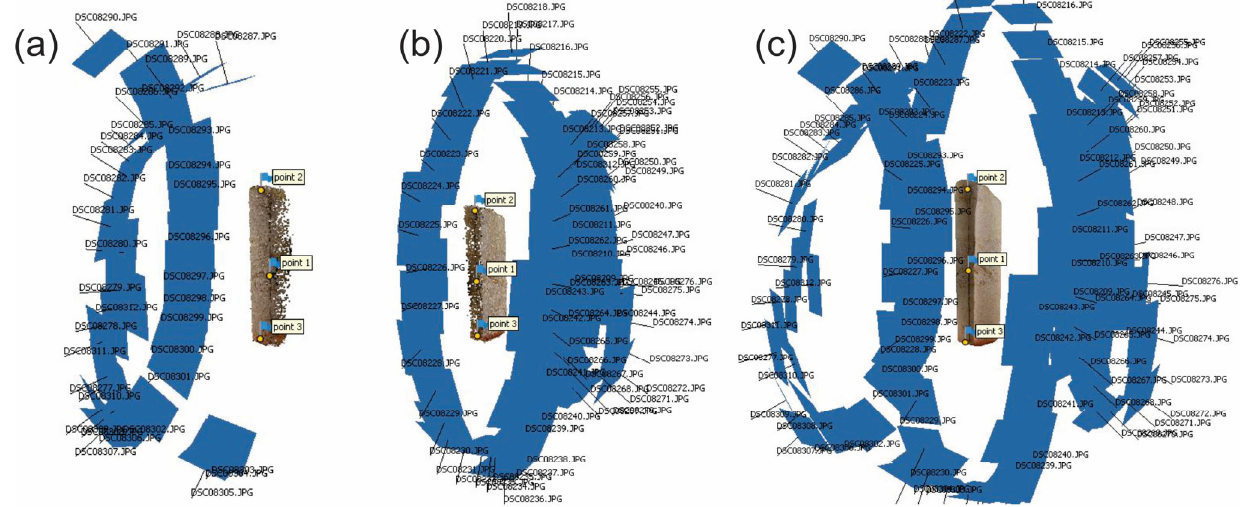
Figure 12. Distribution of images for the reconstruction of a geological sample. The images ( a ) and ( b ) are the two sets of images obtained, as well as the markers (Points 1, 2 and 3) used to merge the two reconstructed segments resulting in the image ( c ).